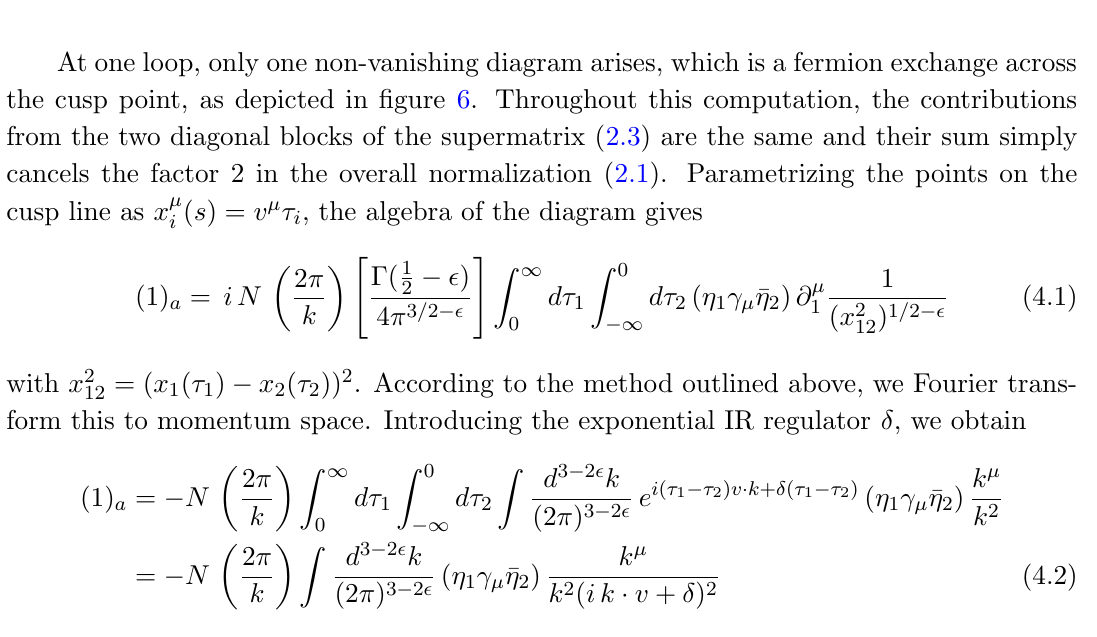
Figure 6 . One-loop fermion exchange diagram (1) a . The double line represents the WL contour, the single line is the fermionic propagator and the black dot is the cusp